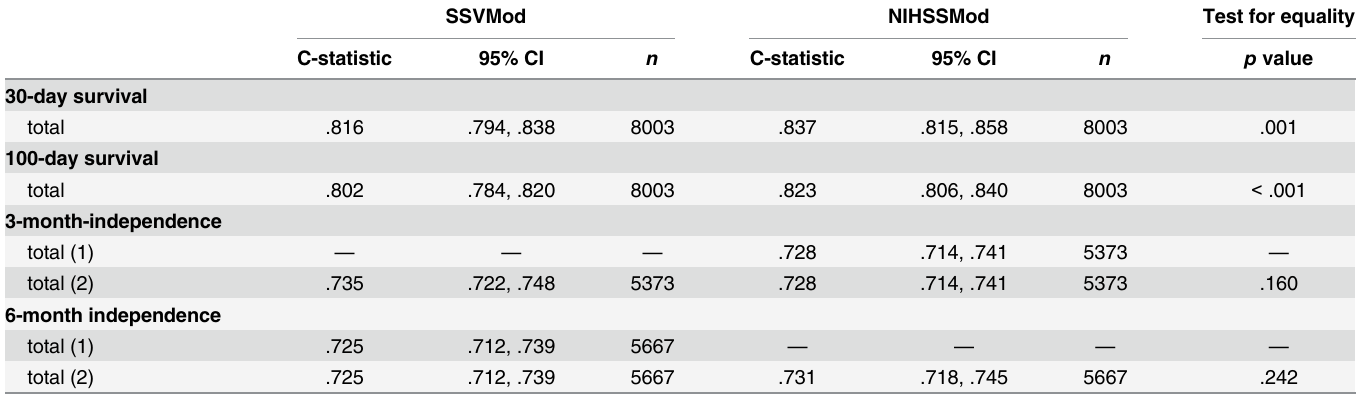
Table 5. C-statistics for survival and independence.